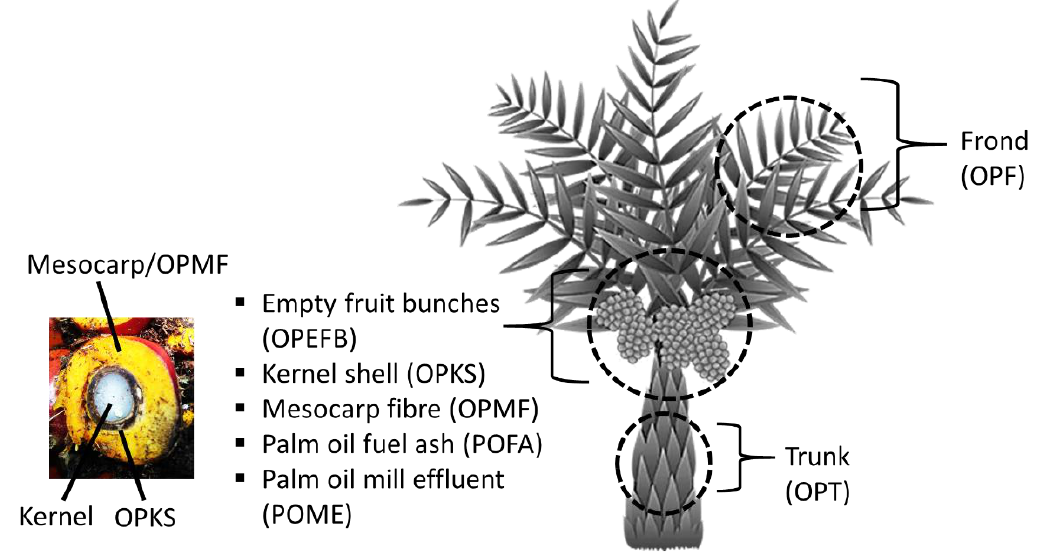
Figure 3. Biowastes generated by the oil palm industry.